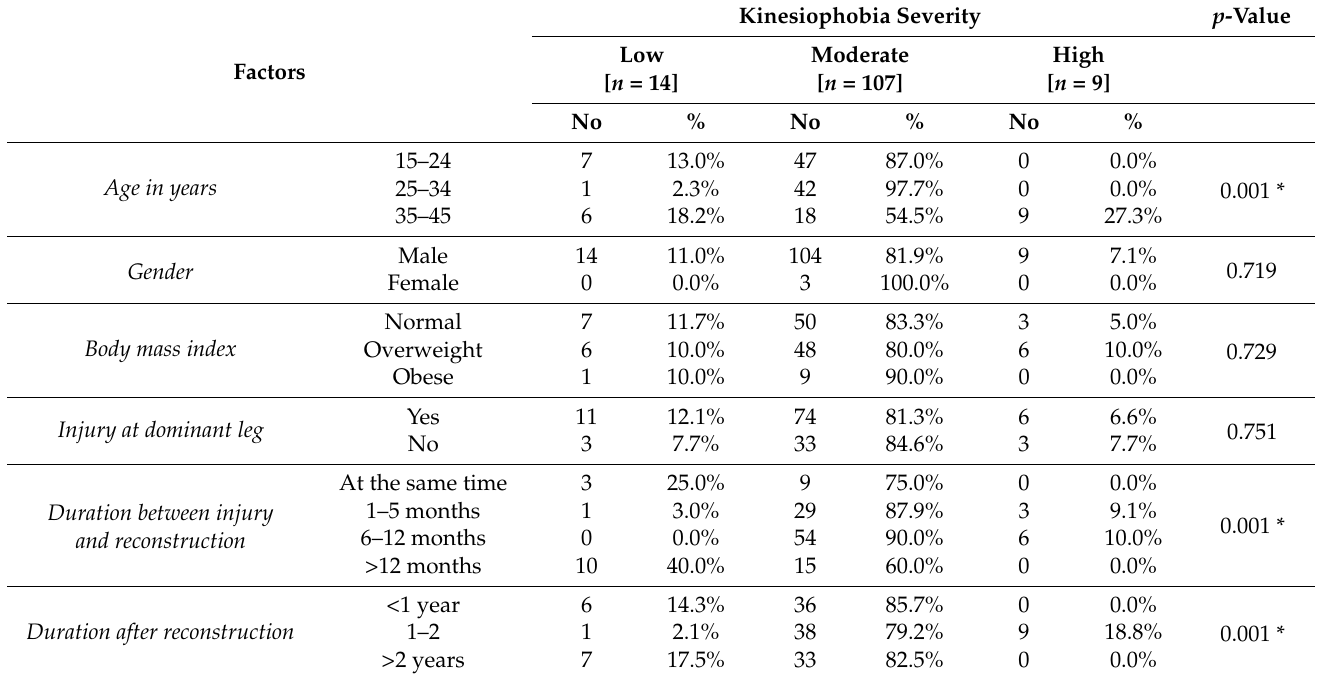
Table 4. Factors associated with kinesiophobia level among patients undergoing ACL reconstruction in Aseer Central Hospital, Saudi Arabia.